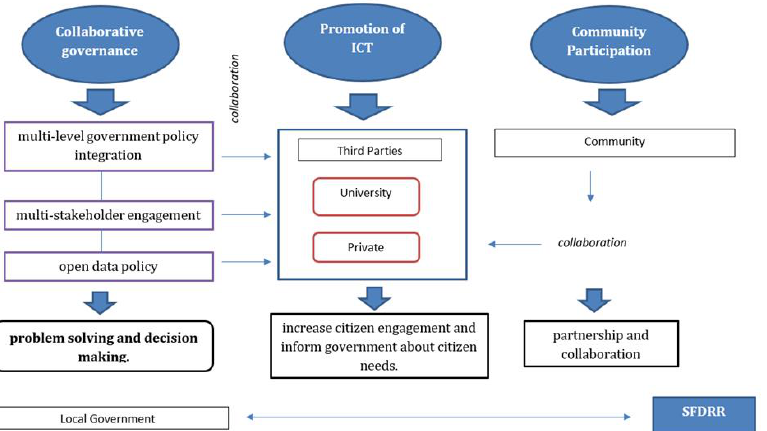
Figure 7. Feasible Framework to Support Smart Climate Communities for Climate Village (Source: authors).